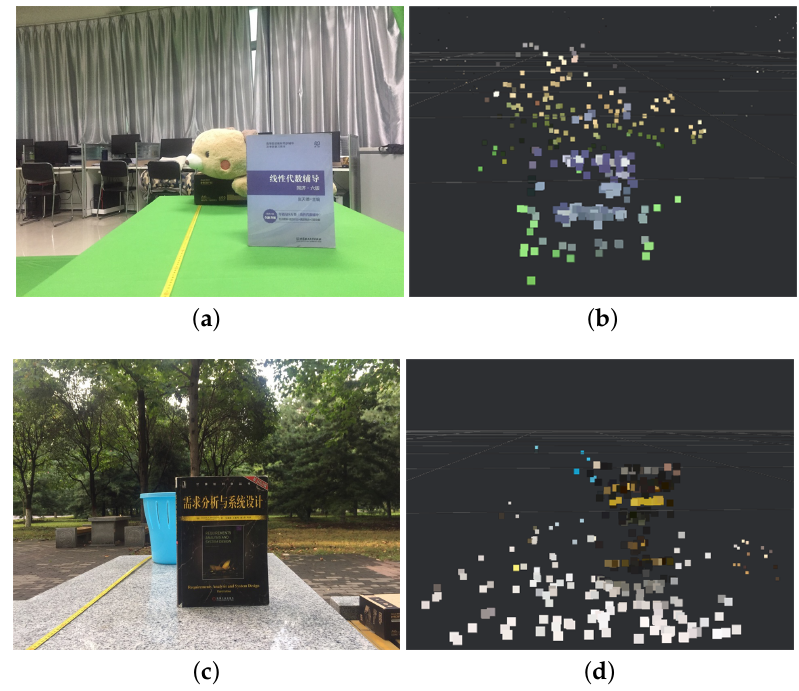
Figure A10. Illustrative reconstruction results achieved by MeshRoom software. Two different images in indoor and outdoor scenes are displayed on the left column ( a , c ), while the corresponding reconstruction results are shown as ( b , d ). It is observed that this method fails to reconstruct the objects in the